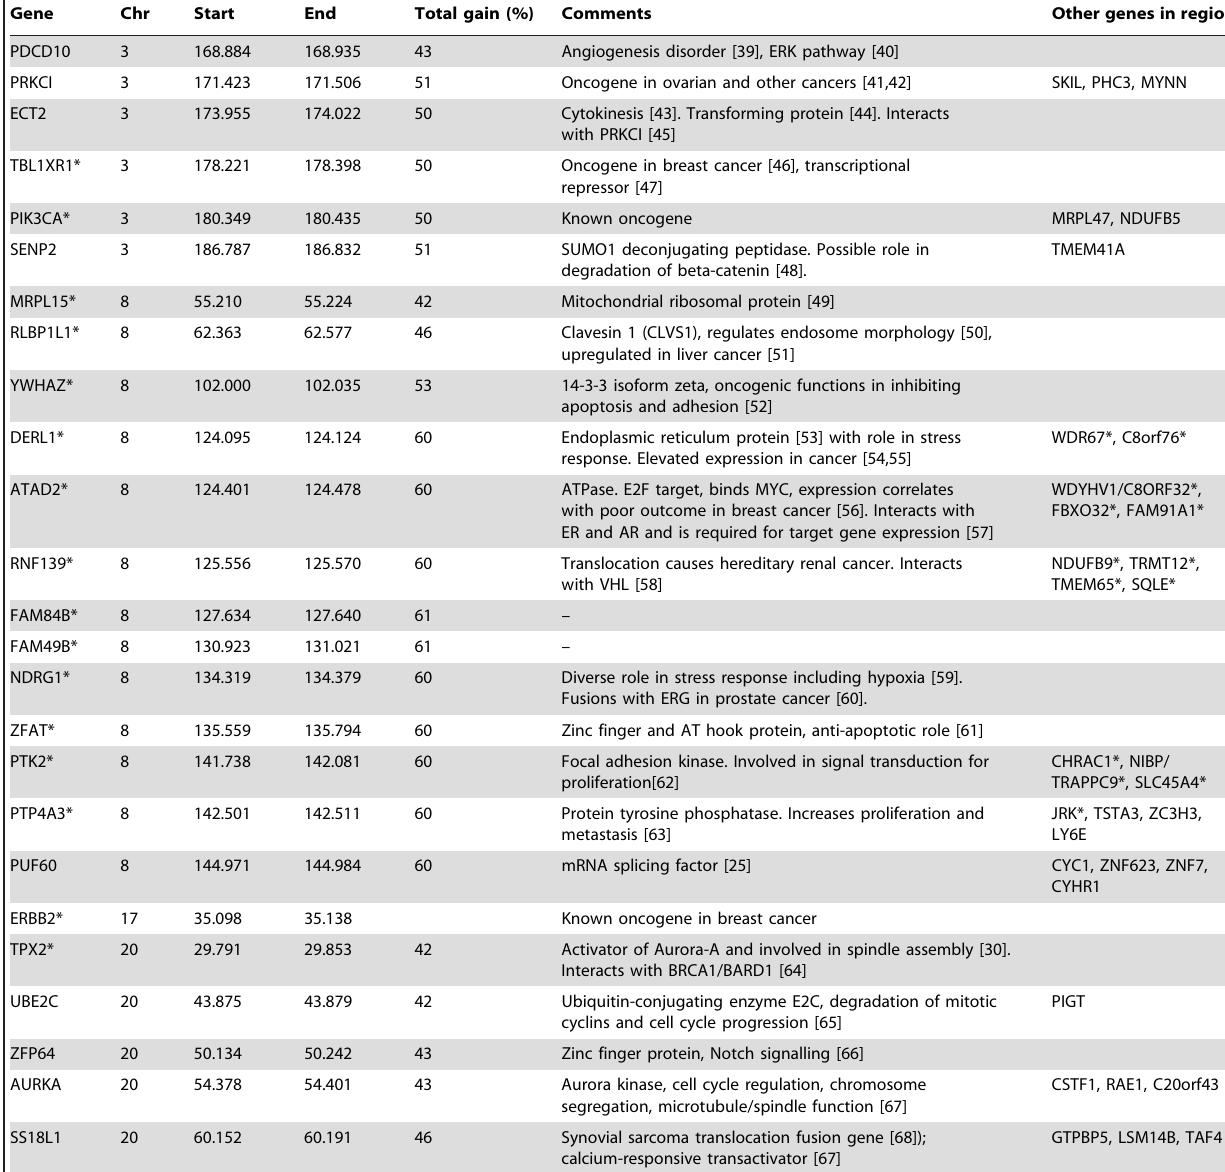
Table 6. Candidate oncogenes and current literature.